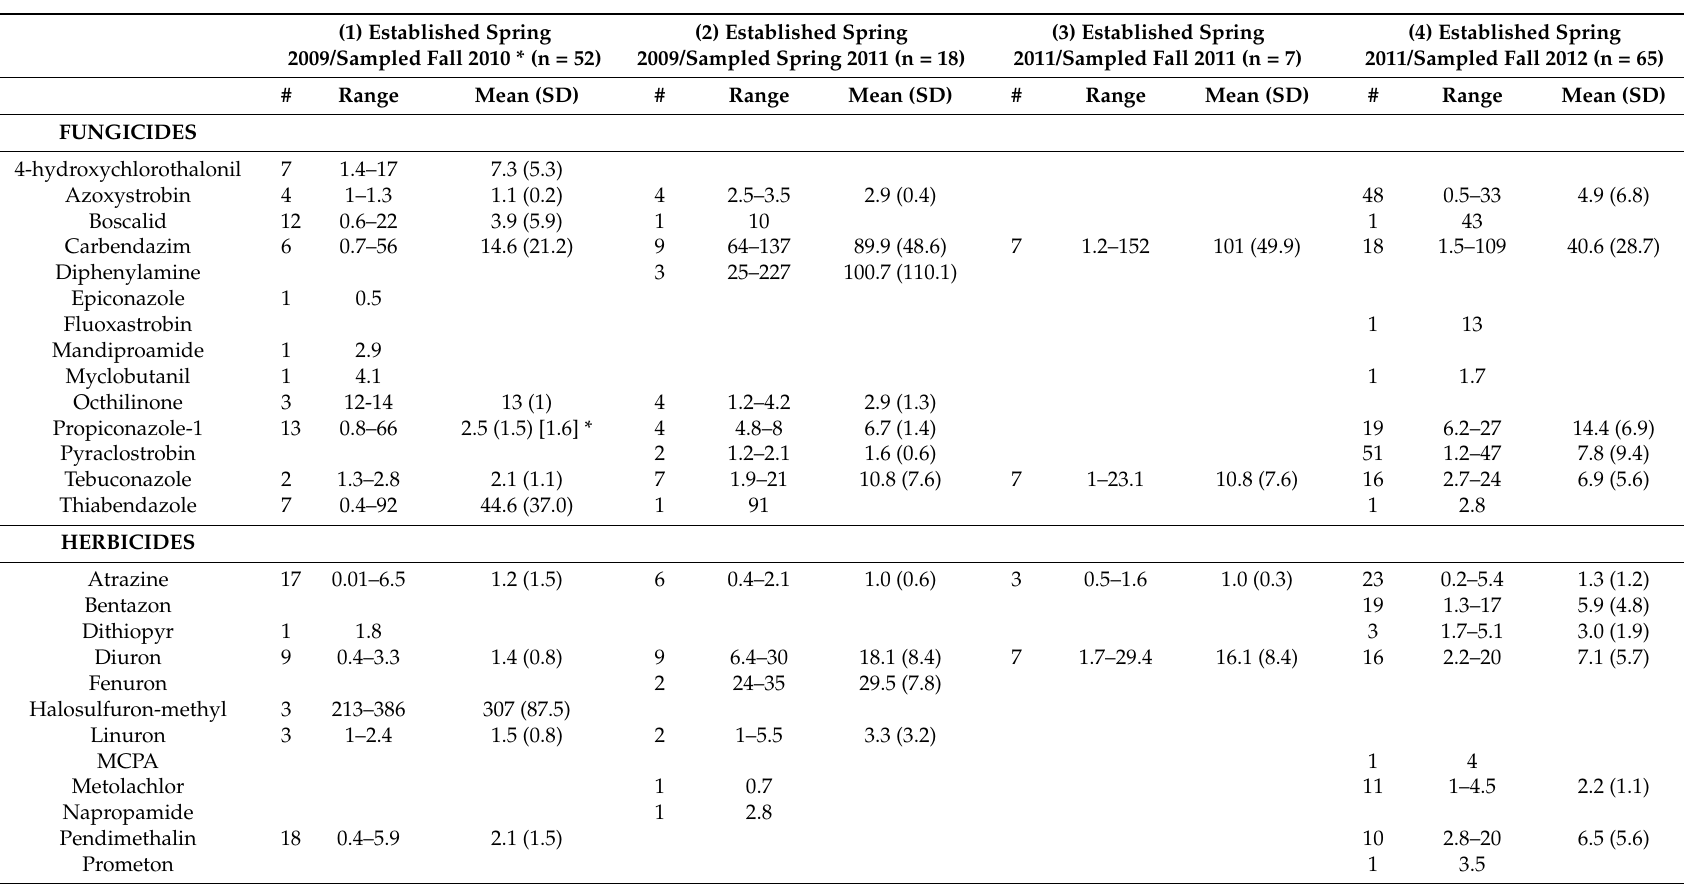
Table 4. Pesticides in wax from active colonies: number of detections (#) and amount detected—highest, lowest and mean (SD) from hives (1) Established Spring 2009 and Sampled Fall 2010 [one hive in Maine established in 2010, in brackets and marked by *], (2) Established in Spring 2009 and Sampled Fall 2011 (3) Established Spring 2011/ Sampled Fall 2011 and (4) Established in Spring 2011 and Sampled Fall